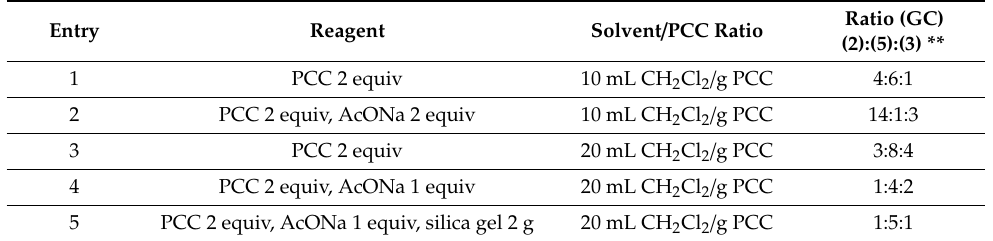
Table 2. Effects of the reagent and solvent/PCC ratio on 1,2-diacetin oxidation*.